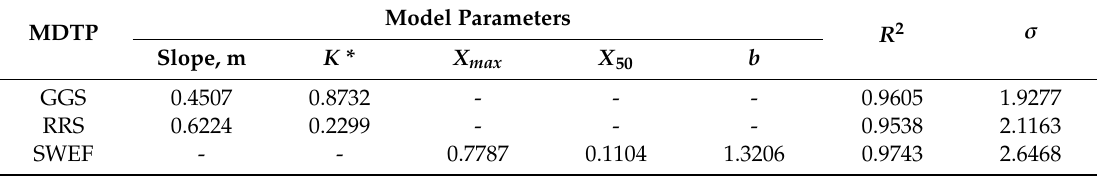
Table 2. Parameters of the distribution models under study, recirculated product.